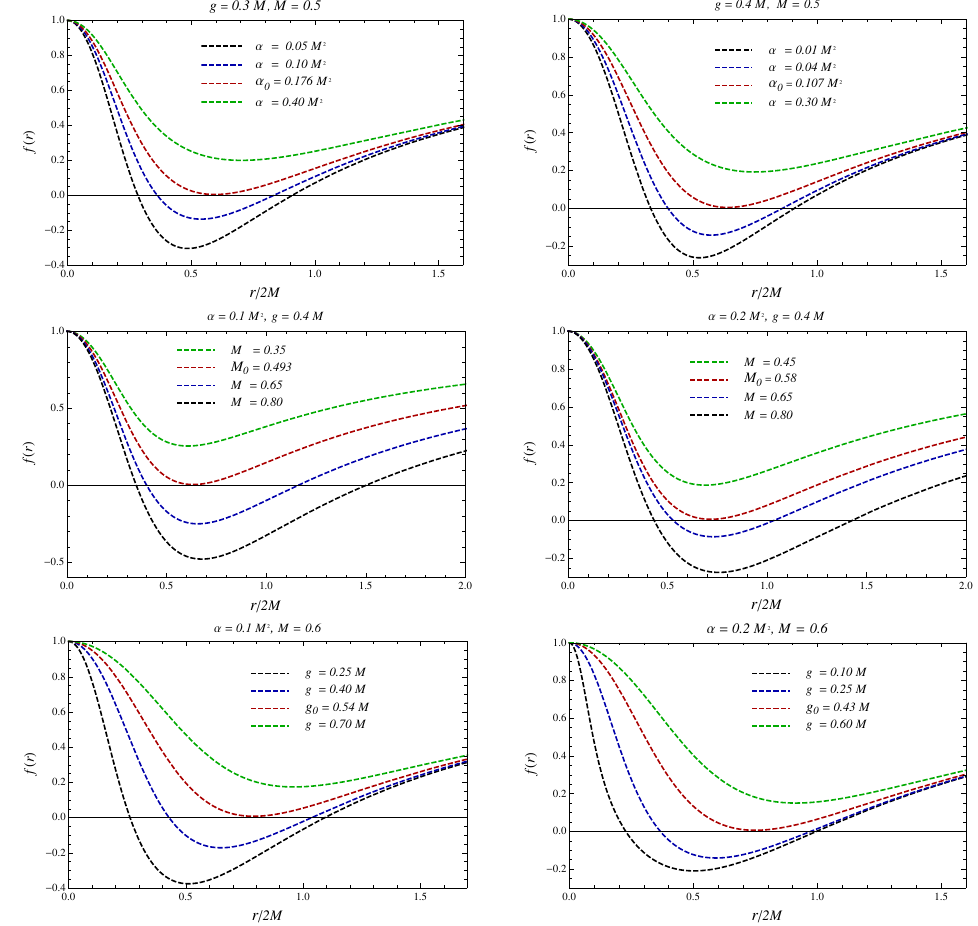
Figure 1. The horizons of the 4 D nonsingular EGB black holes for various values of α , M and g